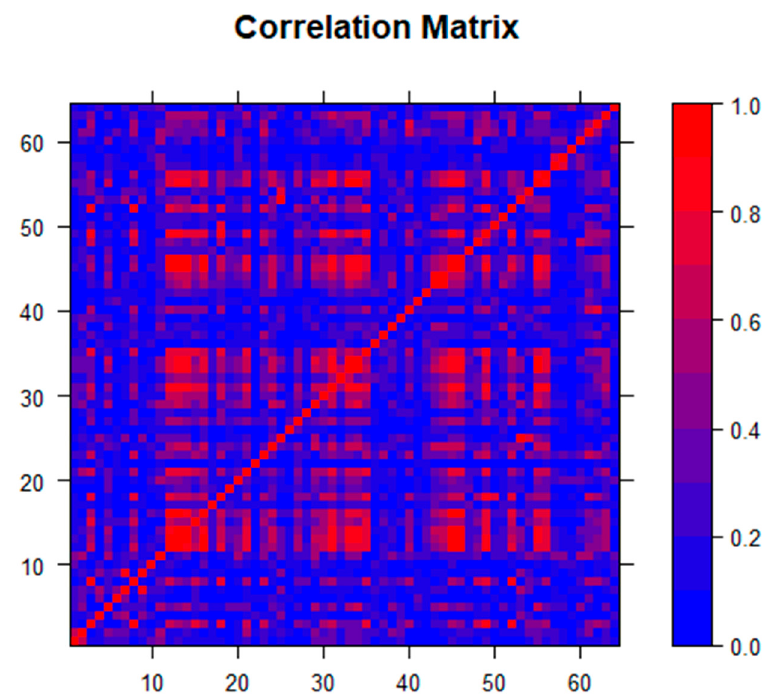
Figure 1. Correlation matrix for the 65 independent predictors used in the analysis, which shows multicollinearity and the need for lasso as the appropriate coefficient shrinkage